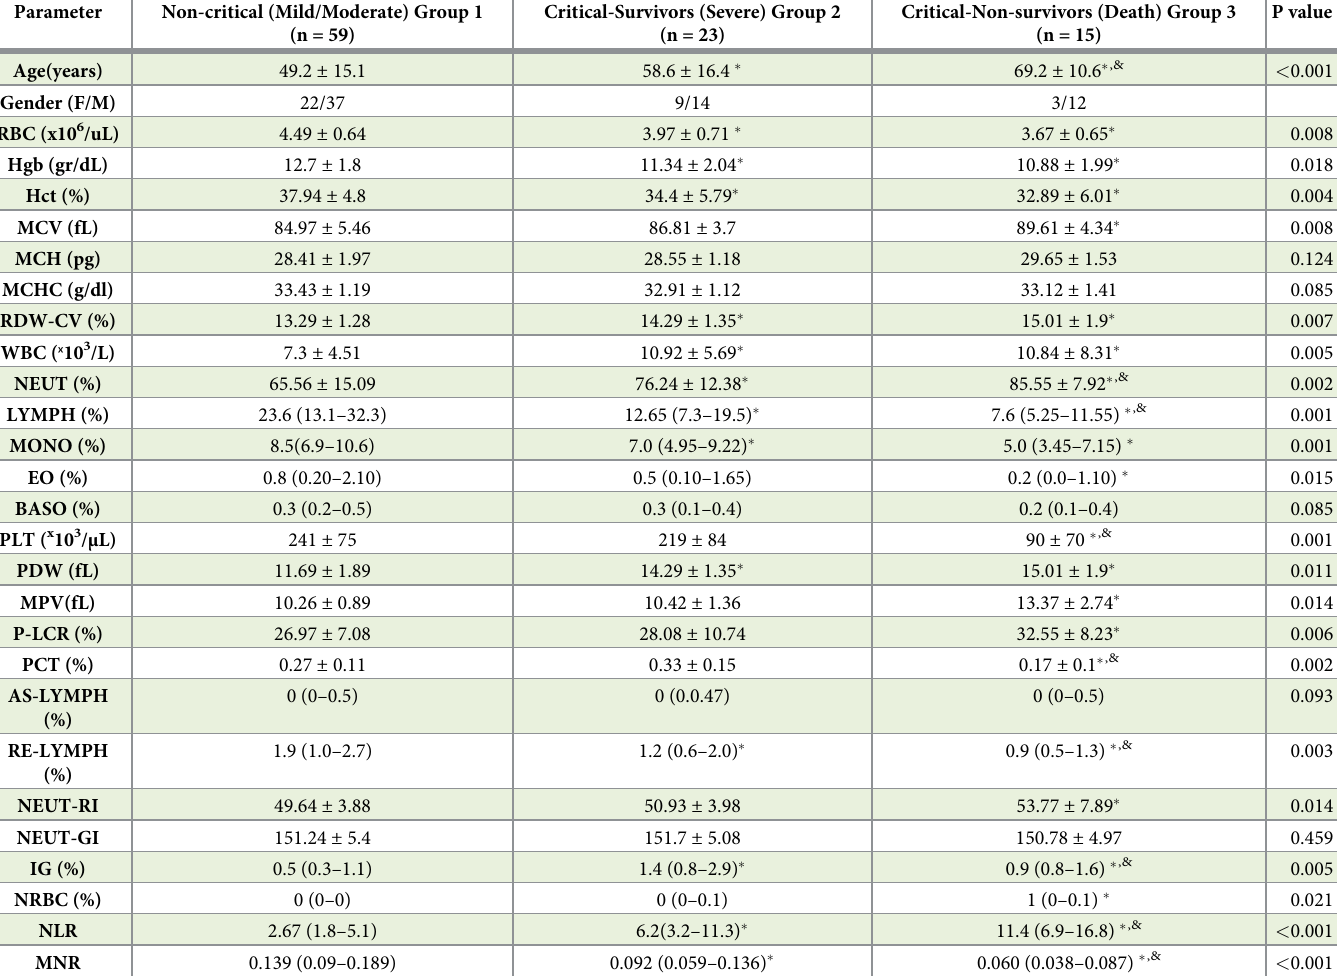
Table 2. Comparison of haematological parameters with standard deviation between mild, moderate/severe and death groups, and survivor/non-survivor groups in COVID-19 patients.